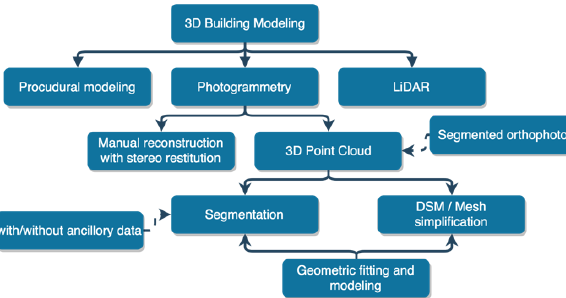
Figure 1. A schema of our photogrammetric-based approach for the generation of 3D building